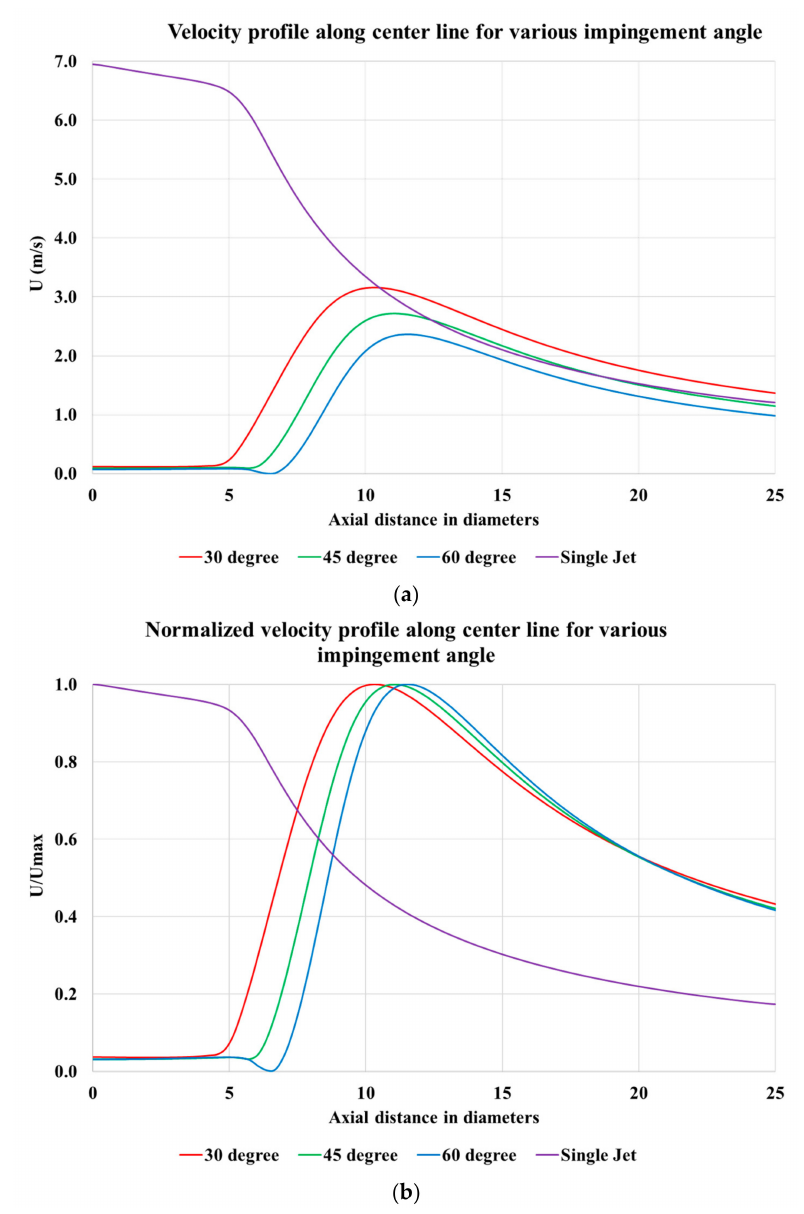
Figure 10. Actual and normalized velocity profile along the center line for various impingement angle: ( a ) actual velocity; and ( b ) normalized